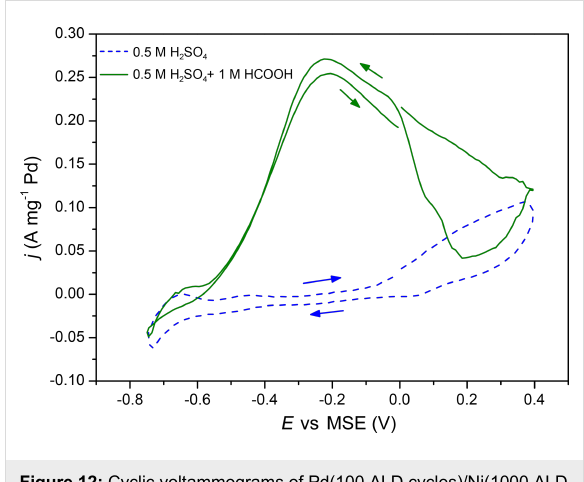
Figure 12: Cyclic voltammograms of Pd(100 ALD cycles)/Ni(1000 ALD cycles) catalysts in 0.5 M H 2 SO 4 without (blue dashed line) and with (continuous green line) 1 M HCOOH at 15 mV·s − 1 . Current densities are given per unit mass of Pd estimated from the QCM measurements.